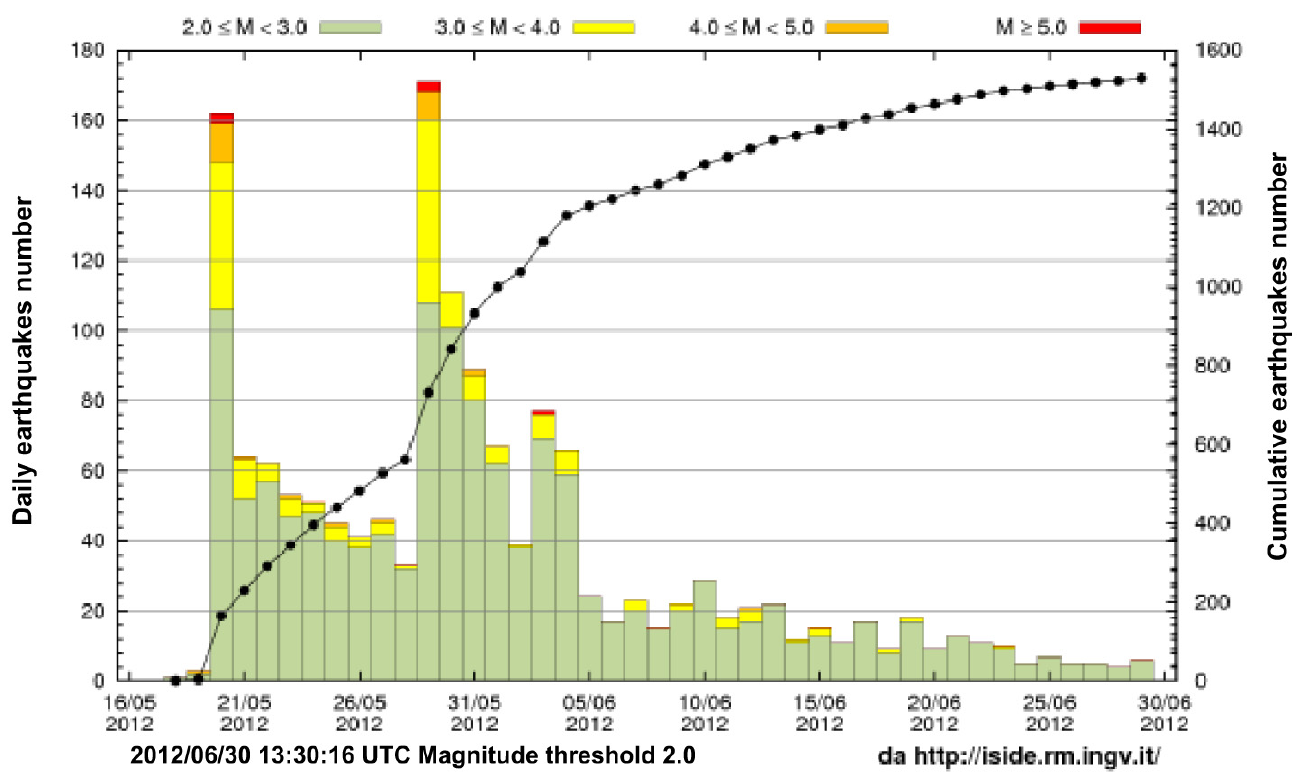
Figure 2. The pattern of seismicity with time (from http://terremoti.ingv.it/it/ultimi-eventi/842-terremoti-in-pianura-padana-emiliana.html). indicat- ing the number of events per day, their magnitude and the cumulative number of events with